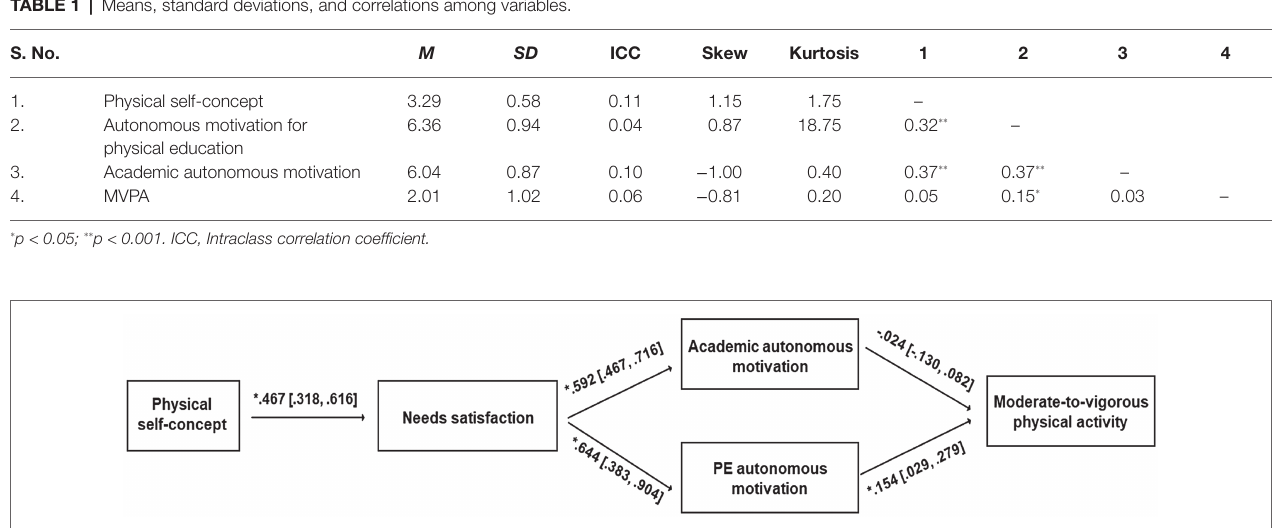
FIGURE 2 | Structural equation model. *The parameters are significant at p < 0.05 and